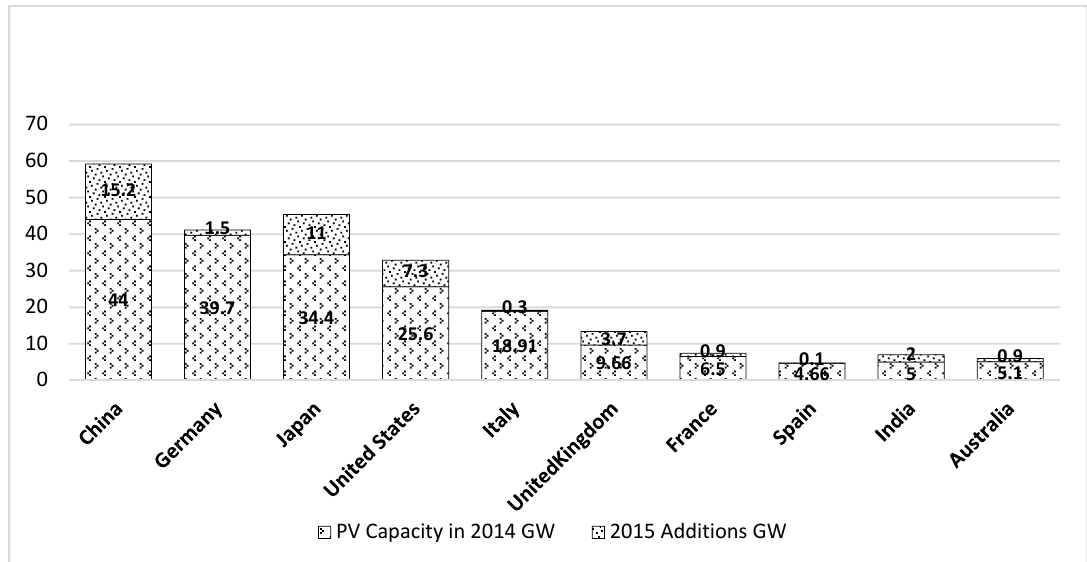
Figure 15 . Top solar photovoltaic (PV) capacity in 2014 and additions in 2015. Figure 15. Top solar photovoltaic (PV) capacity in 2014 and additions in